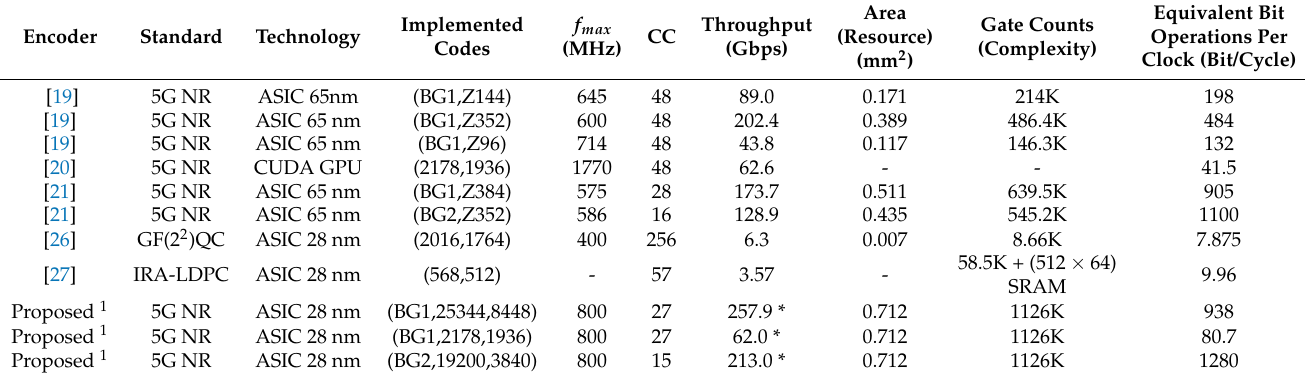
Table 1. Comparison of hardware implementation of 5G QC-LDPC and other standard LDPC encoders.